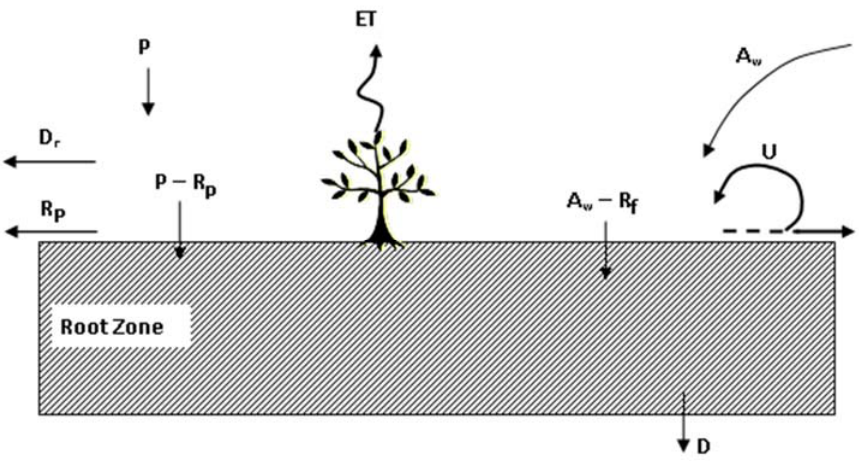
Figure 2. Schematic representation of land surface and root zone flow processes simulated by IWFM.